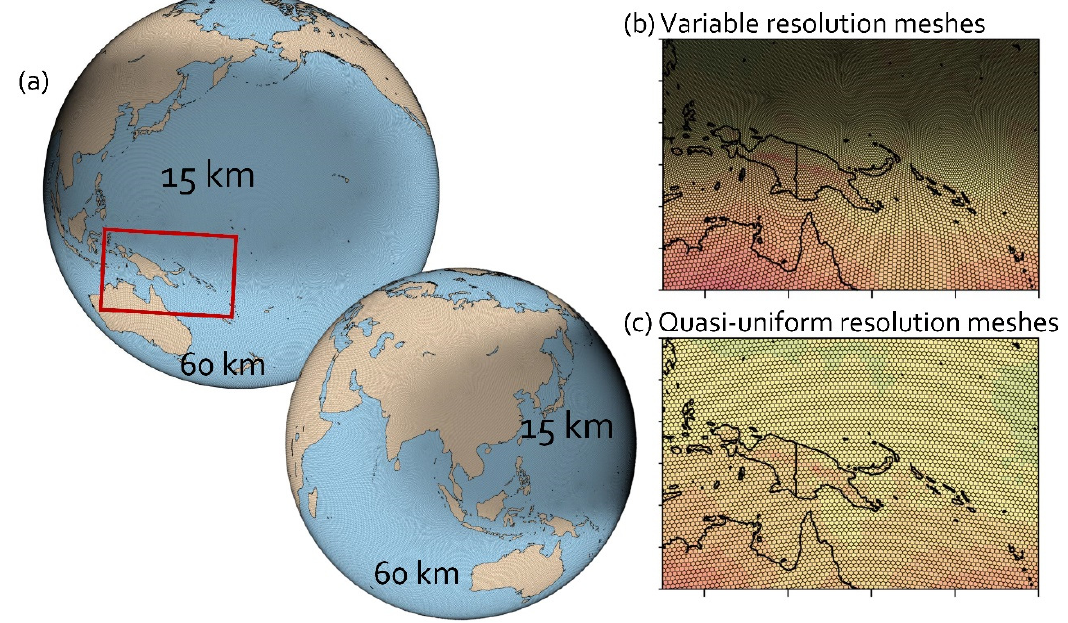
Figure 1. ( a ) 60–15 km variable resolution meshes of MPAS on a globe and meshes over a transient area (marked by the red box in ( a )) ( b ) with variable resolution and ( c ) without variable resolution (i.e., quasi-uniform